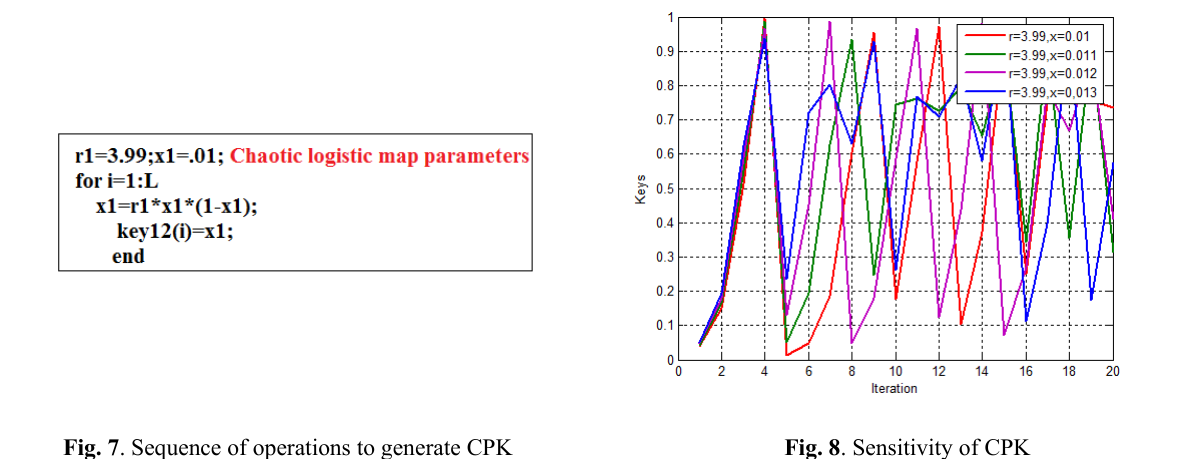
Fig. 7 . Sequence of operations to generate CPK Fig. 8 . Sensitivity of